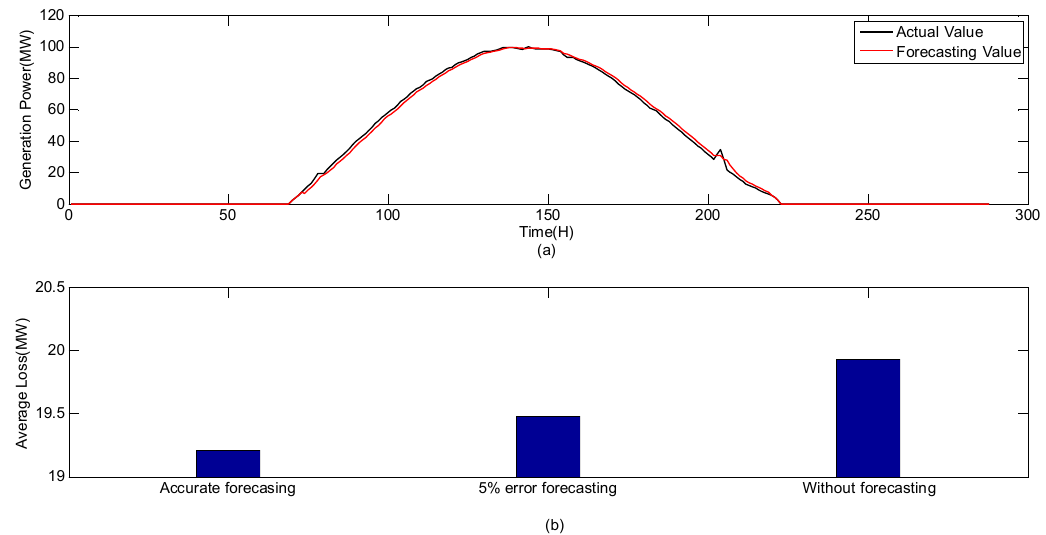
Figure 7. Forecasting results under 5-min action delay on a sunny day. ( a ) Comparison of the actual generation power and predicted values after 150 iteration times of one day; ( b ) comparison of the average power losses under different forecasting accuracy.